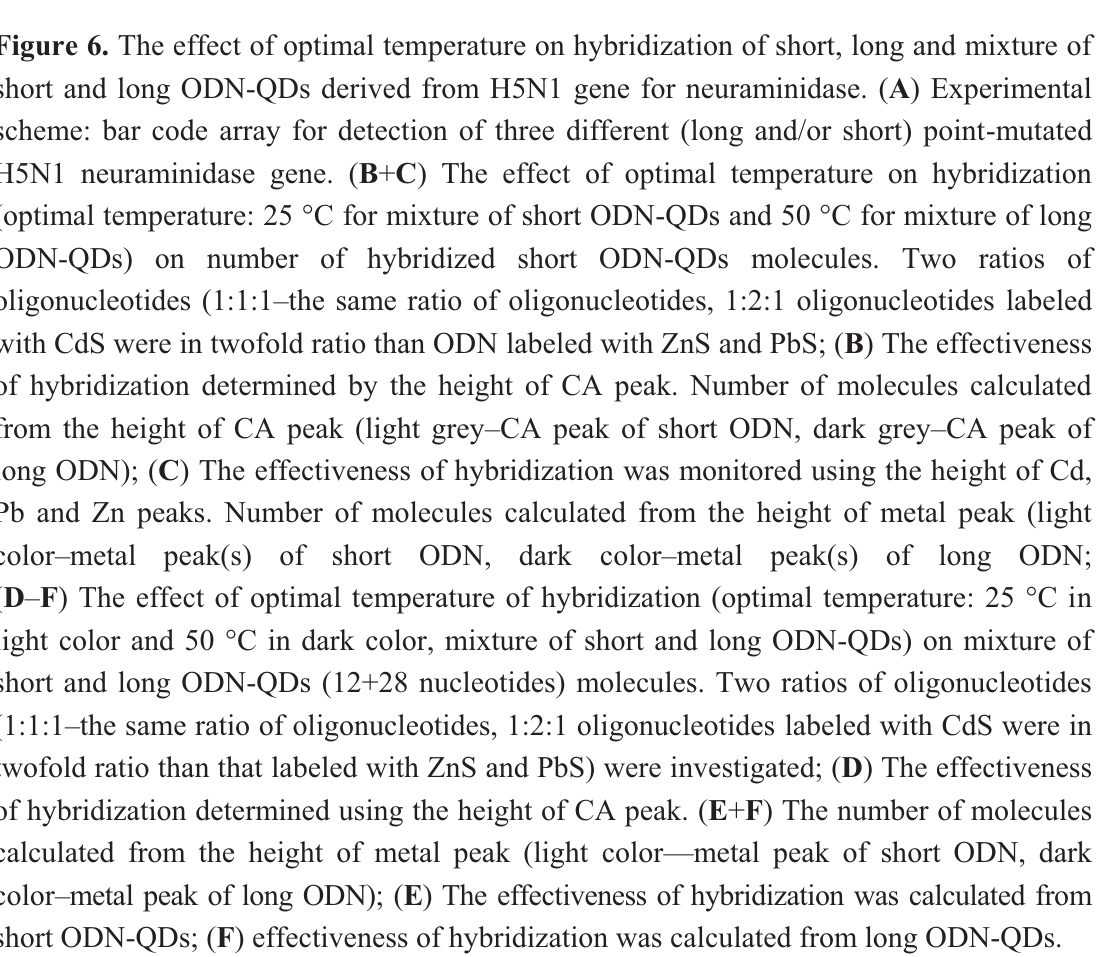
Figure 6. The effect of optimal temperature on hybridization of short, long and mixture of short and long ODN-QDs derived from H5N1 gene for neuraminidase. ( A ) Experimental scheme: bar code array for detection of three different (long and/or short) point-mutated H5N1 neuraminidase gene. ( B + C ) The effect of optimal temperature on